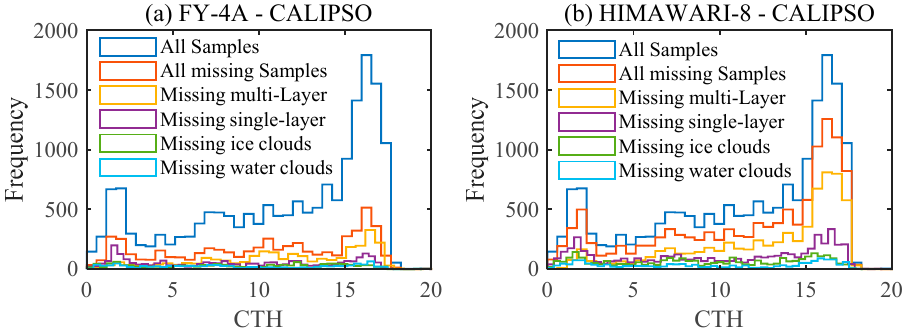
Figure 8. The frequency distribution of missing data of FY-4A and HIMAWARI-8 varies with CTH. ( a ) FY-4A and ( b ) HIMAWARI-8.